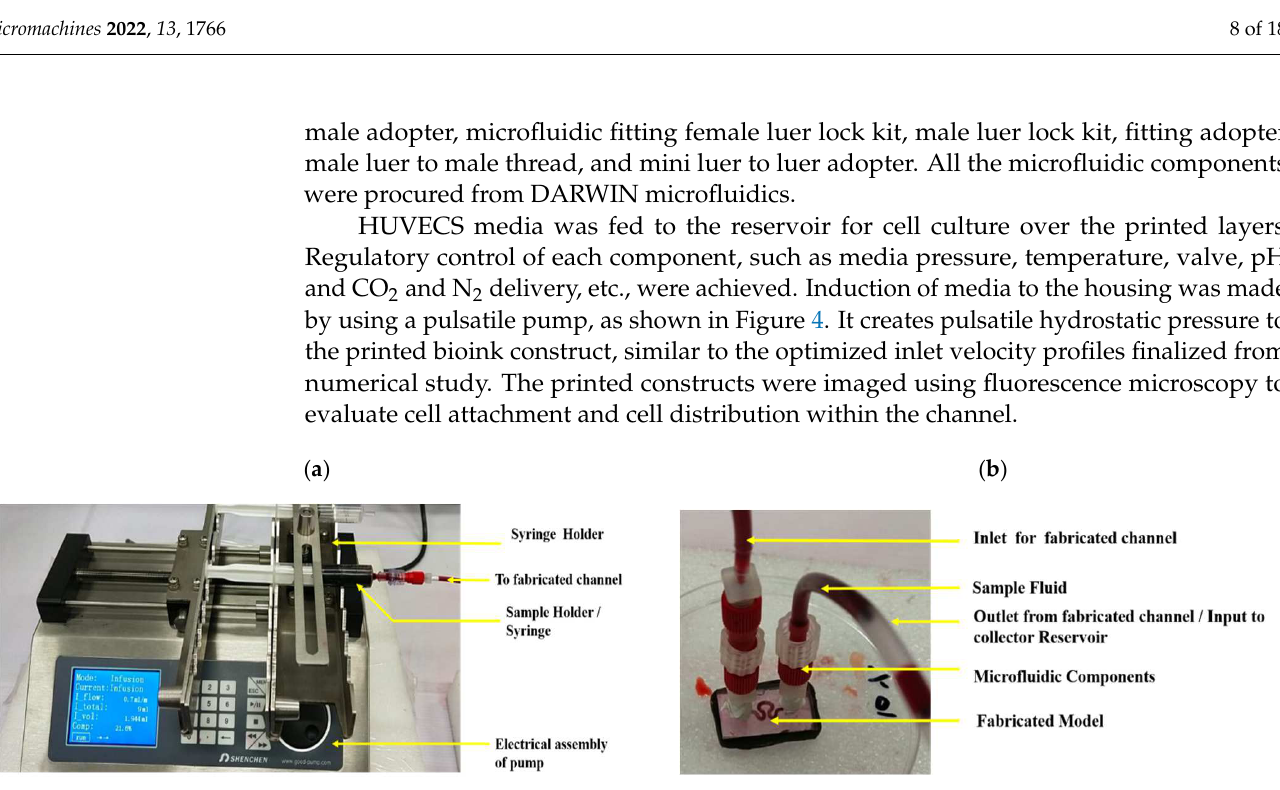
Figure 4. Experimental set up details ( a ) syringe pump setup, ( b ) magnifying image of microfluidic